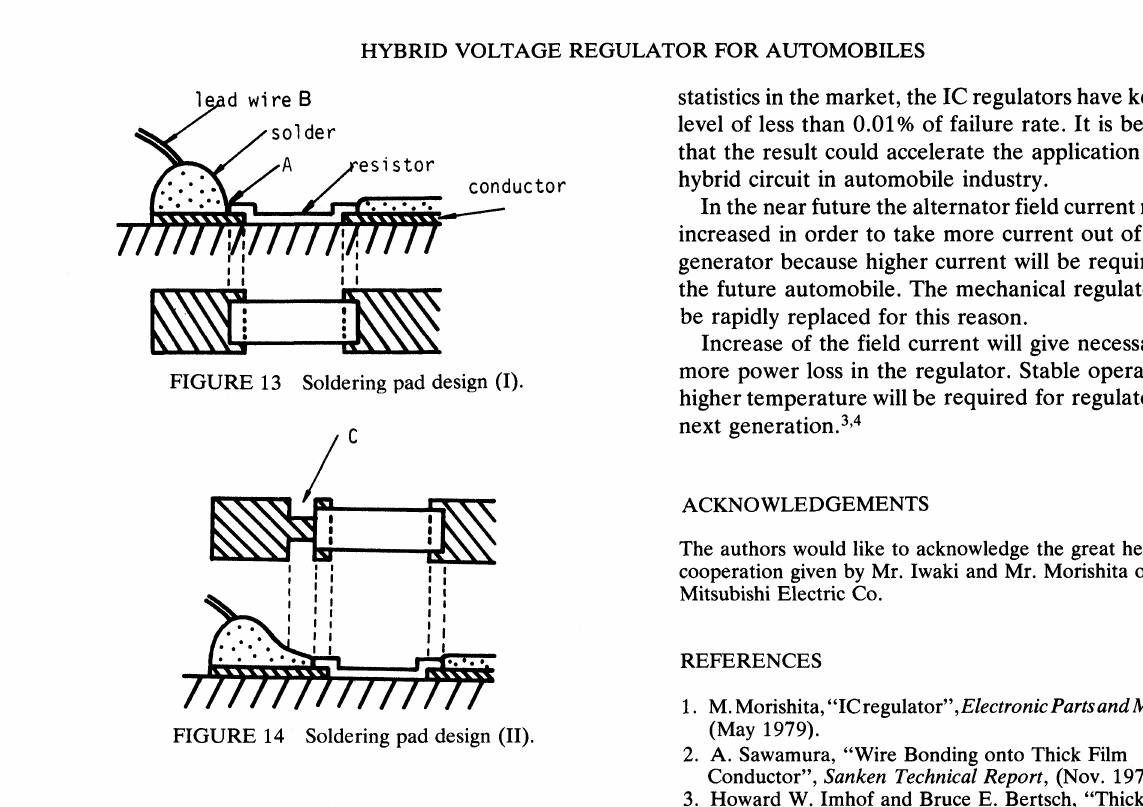
FIGURE 14 Soldering pad design